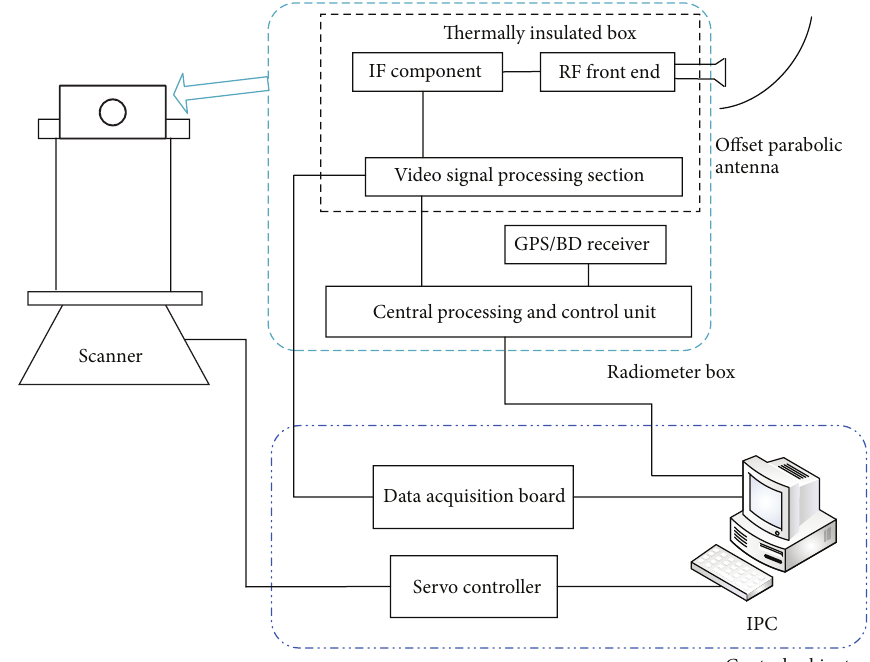
Figure 1: Block diagram of the W-band radiometric imaging system.